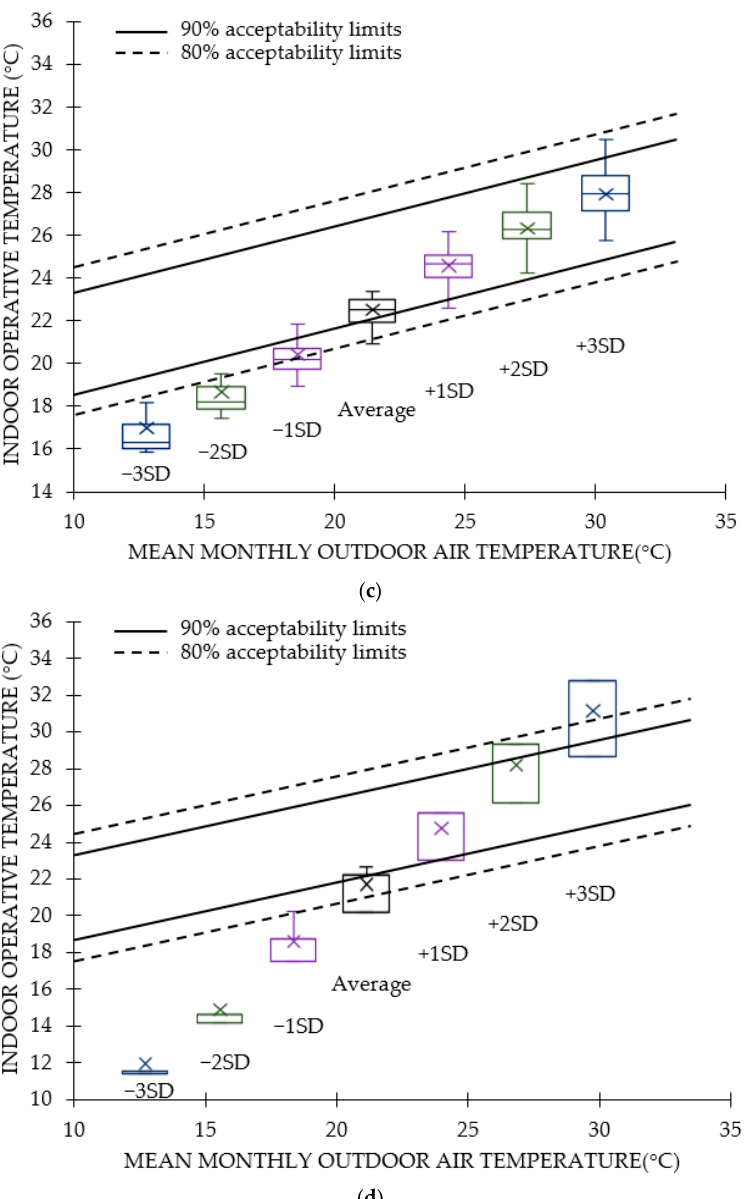
Figure 9. Mixed-mode ventilation evaluation based on the average values and one ( ± 1), two ( ± 2), and three ( ± 3) standard deviation values of indoor operative temperature in four cases of using: ( a ) 100% indoor air, ( b ) 70% indoor air and 30% outdoor air, ( c ) 50% indoor air and 50% outdoor air, and ( d ) 100% outdoor air.